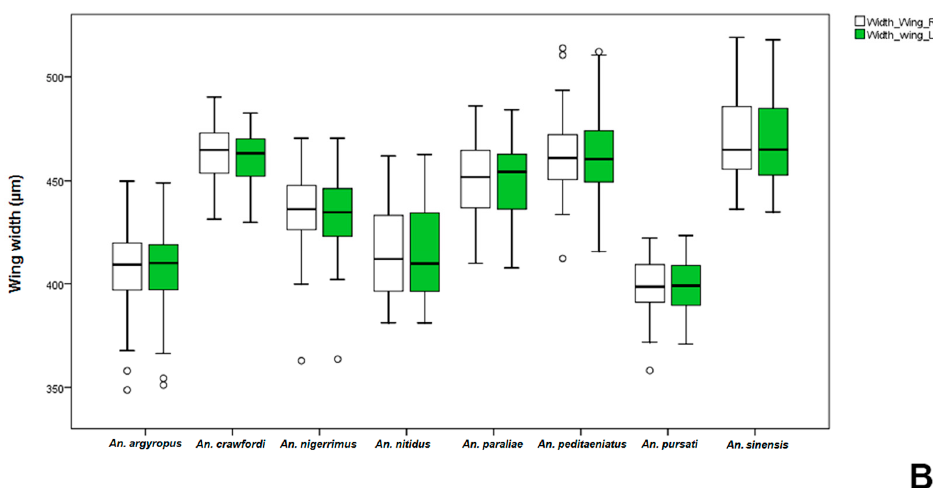
Figure 4. The Box-and-Whisker Plots representation of variation in wing length ( A ) and width ( B ) of adult female of the eight Hyrcanus Group species.